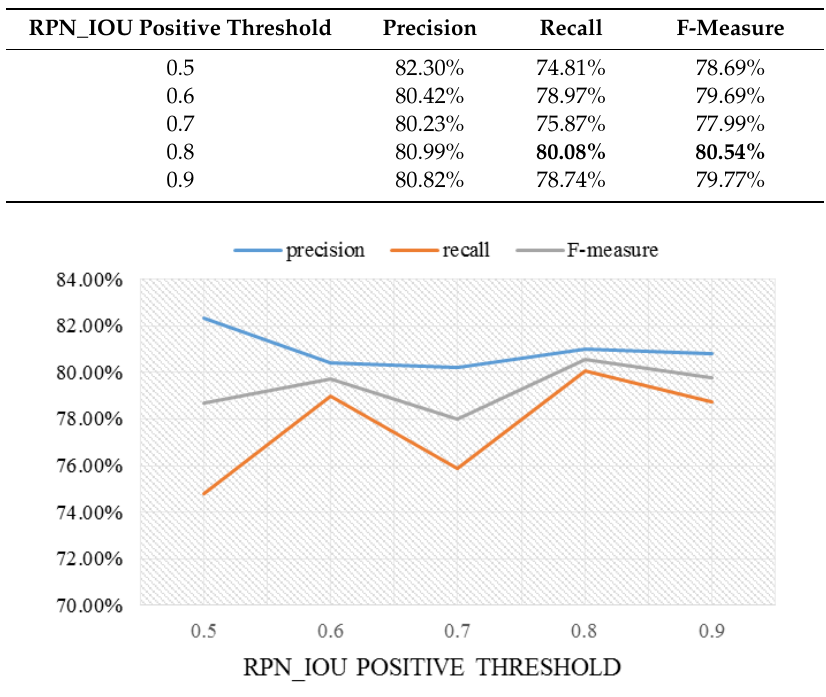
Figure 10. The results with the different RPN_IOU positive thresholds.